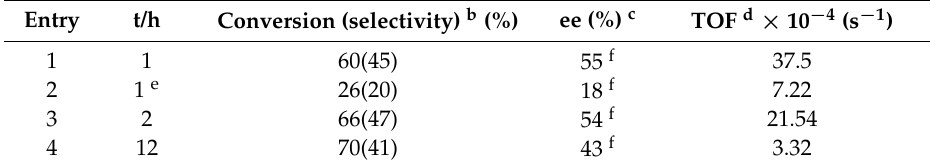
Table 3. Asymmetric epoxidation of α -methylstyrene by catalyst 1 with m -CPBA as oxidant systems a .